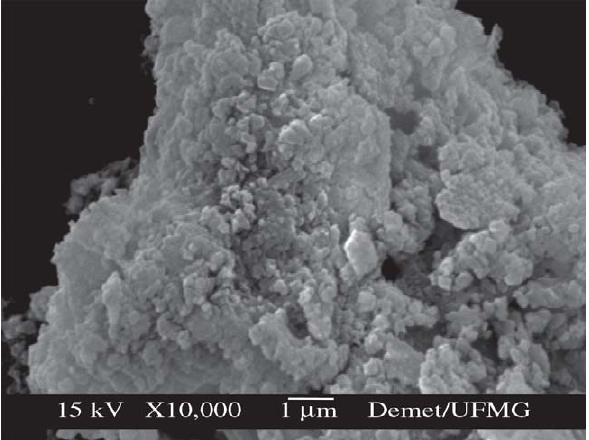
Figure 2. SEM micrograph of sample A4 of synthesized HA pow- der after thermal